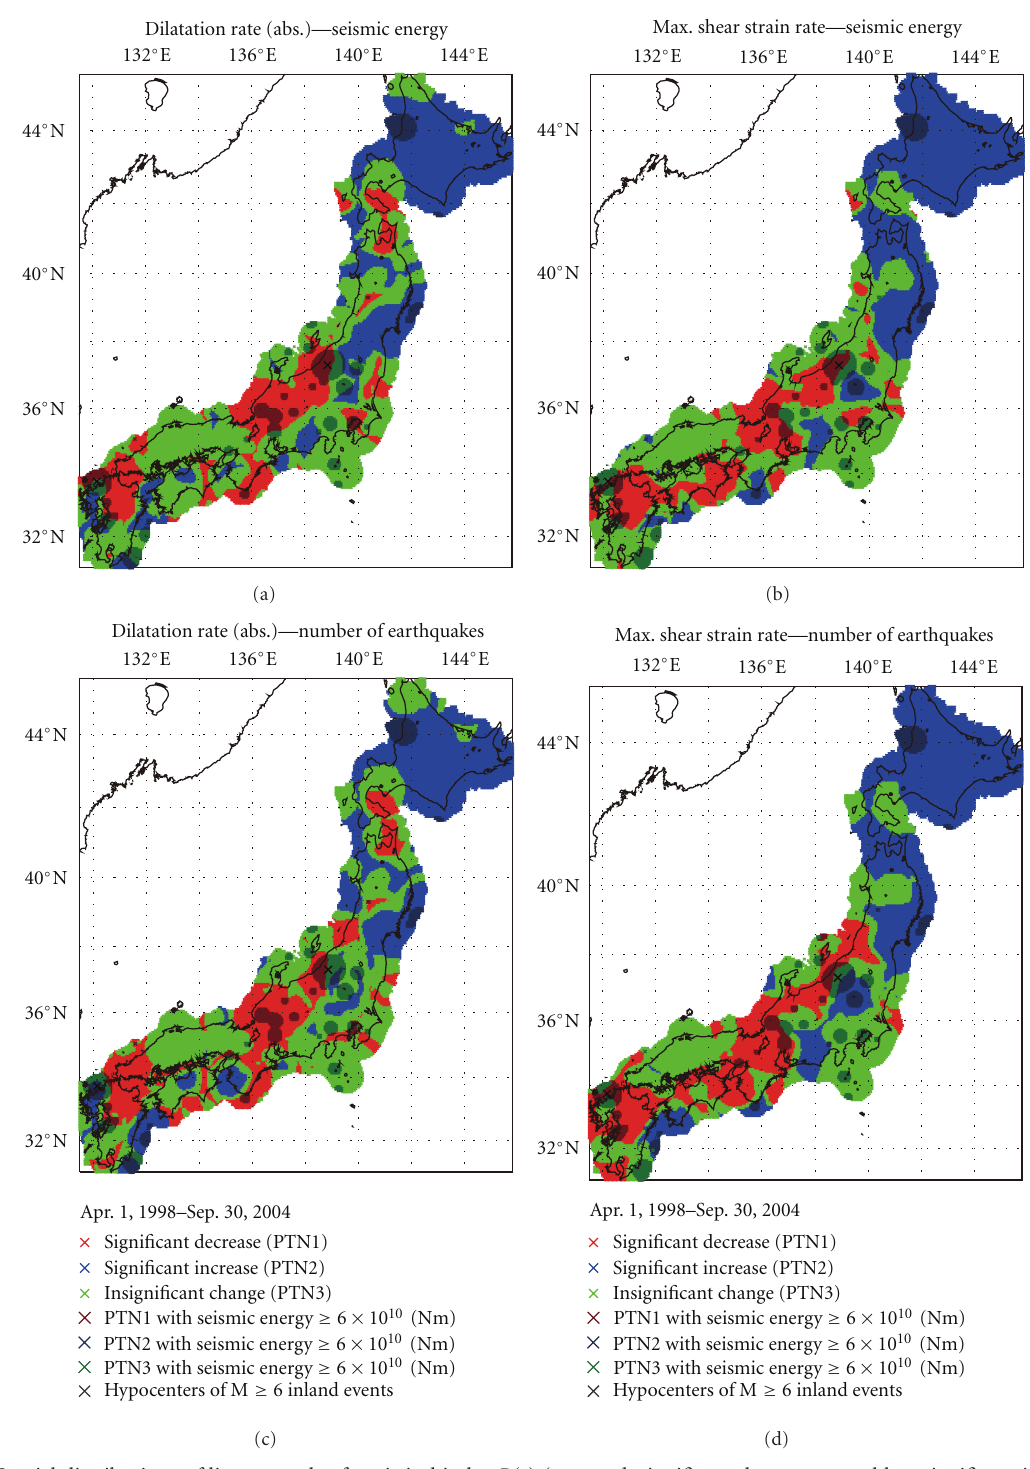
Figure 3: Spatial distributions of linear trends of statistical index R ( t ) (pure red: significant decrease, pure blue: significant increase, pure green: insignificant change), which is obtained by comparison between (a) the absolute value of dilatation rate and seismic energy per two years, (b) maximum shear strain rate and seismic energy per two years, (c) absolute value of dilatation rate and number of earthquakes per two years, (d) maximum shear strain rate and number of earthquakes per two years. Time period for calculating linear trends of R ( t ) is from 1 April 1998 through 30 September 2004, which is shown in panel (c) and (d). Superimposed in dark colors are the same distributions of areas in which seismic energy more than or equal to M4.0 earthquake (6 × 10 10 Nm) was radiated during one year after the time period shown in panel (c) and (d). Linear trends of R ( t ), which were obtained by least squares fitting, were classified using T approval with a confidence level of 95%. The numbers of dark-red, dark-blue, and dark-green grids, which are normalized by those of their corresponding pure-color ones, are here defined as no. PTN1, no. PTN2, and no. PTN3, respectively, for convenience in Figures 4 and